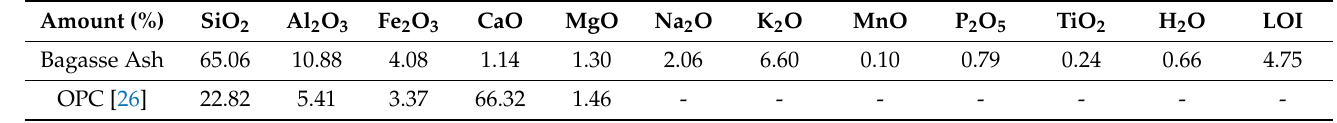
Table 3. Chemical compositions of sugarcane bagasse ash (SCBA) and Dangote OPC cement. Amount (%) SiO 2 Bagasse